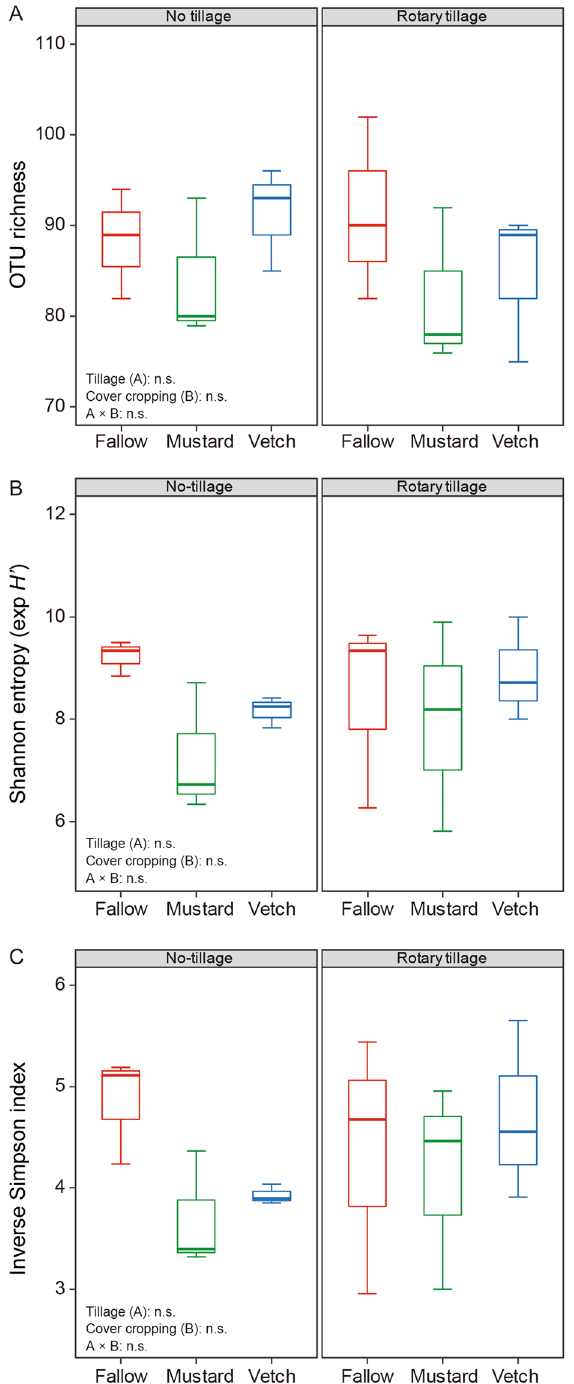
Figure 3. Influence of cover crops and tillage management on the Hill numbers in the maize roots at the eight fully emerged leaves stage. ( A ) The Hill number 0D as operational taxonomic unit (OTU) richness, ( B ) Shannon index (the exponential of Shannon entropy), and ( C ) Simpson index (the inverse Simpson concentration). n.s. means no significant differences by two-way analysis of variance. Horizontal bold lines explain the median number; vertical lines explain minimum and maximum numbers in the plots and box margins ± standard errors. n.s. indicates no significant difference by two-way analysis of variance. All analyses and Fig. 3 were run and created in the software environment RStudio (Version 1.2.1335 – © 2009–2019 RStudio, Inc.) (http://www.